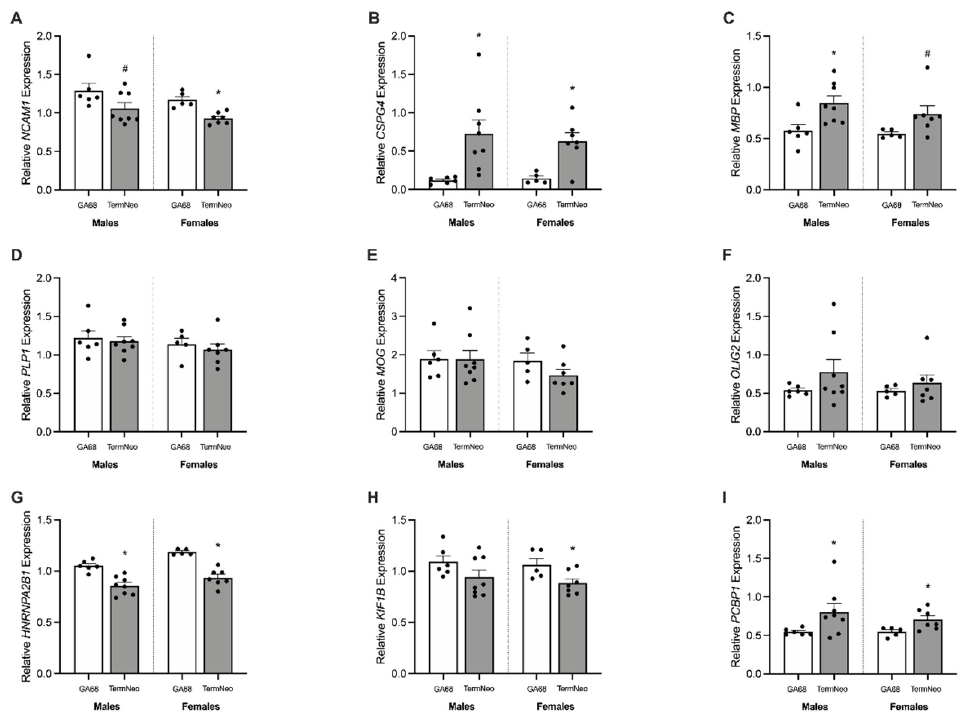
Figure 2. Relative mRNA expression for oligodendrocyte lineage and MBP translation markers in the hippocampus of fetal GA68 (white; males n = 6, females n = 5) and term neonates (grey; males n = 8, females n = 7). ( A ) NCAM1 , ( B ) CSPG4 , ( C ) MBP , ( D ) PLP1 , ( E ) MOG , ( F ) OLIG2 , ( G ) HNRNPA2B1 , ( H ) KIF1B , and ( I ) PCBP1 . Data presented as means ± SEM with * indicating significance at p < 0.05, and # representing a non-significant trend.